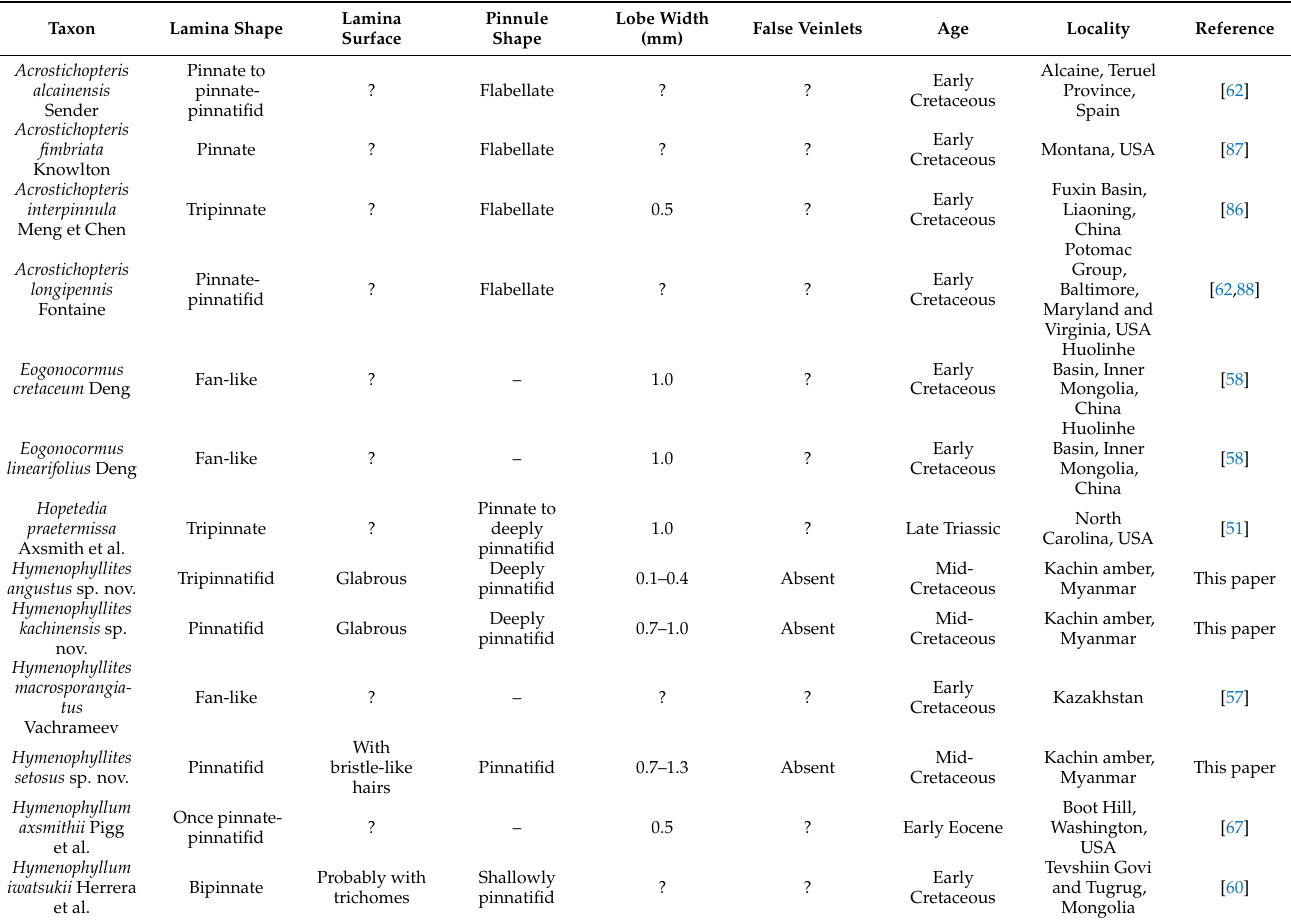
Table 1. Comparison of the present fossils with related Hymenophyllaceae